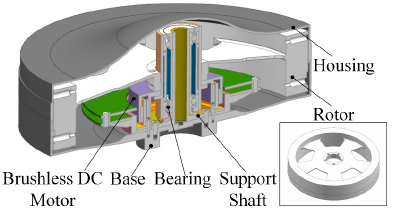
Figure 9. Structure of a reaction wheel. DC: direct current.